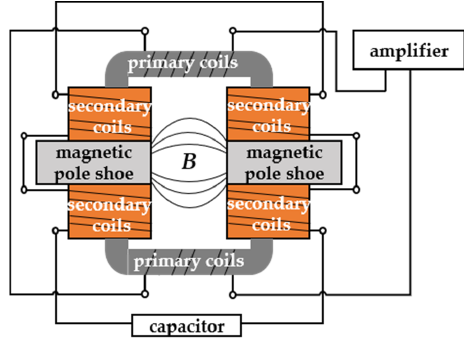
Figure 8. Schematic design of the AC magnet system.